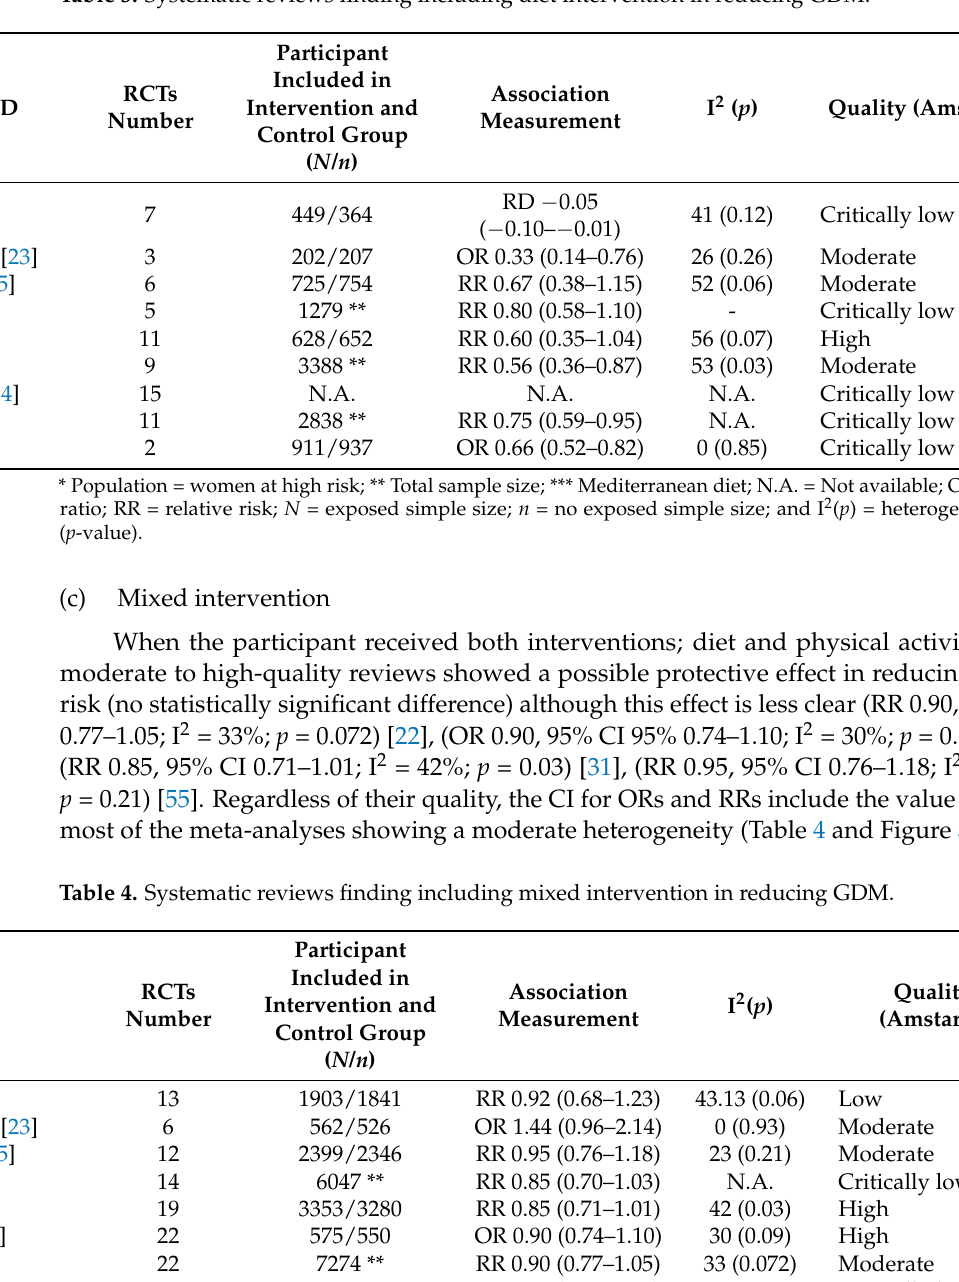
Table 3. Systematic reviews finding including diet intervention in reducing GDM.